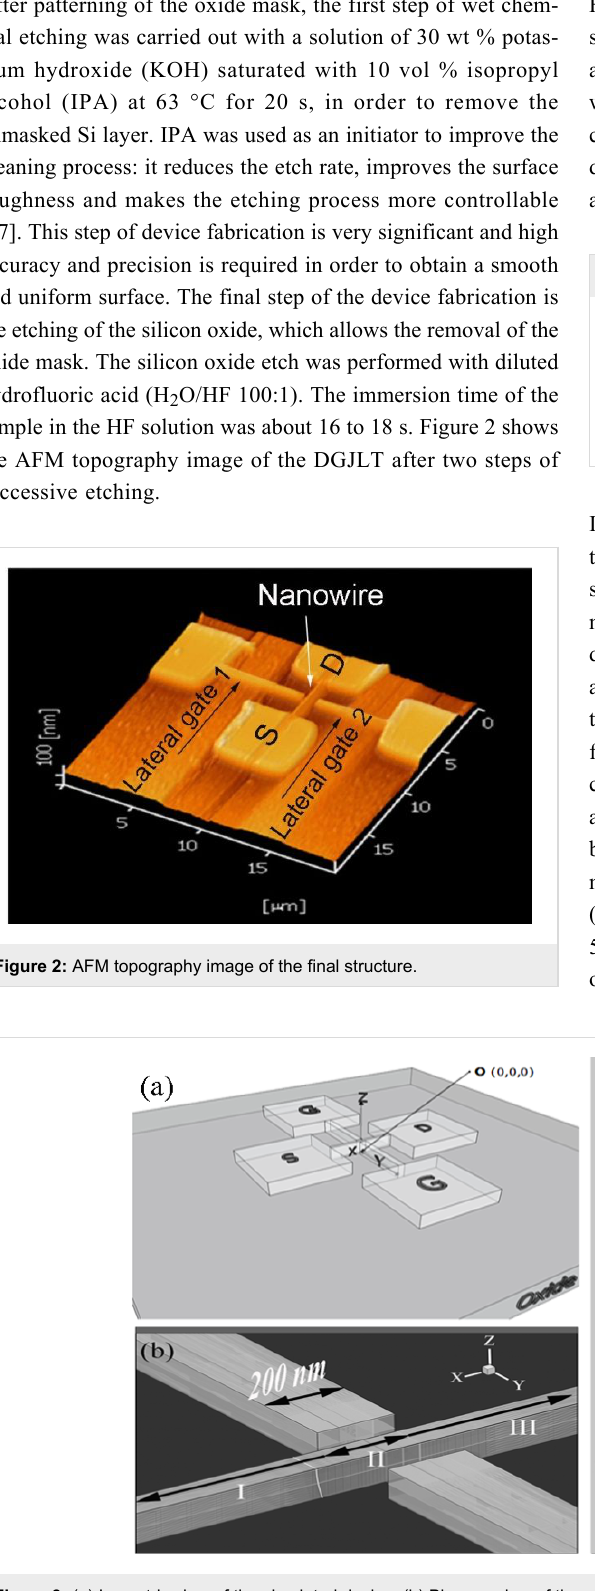
Figure 3: (a) Isometric view of the simulated device. (b) Blow up view of the gated area and different nanowire zones. (c) Top view of the simulated device.